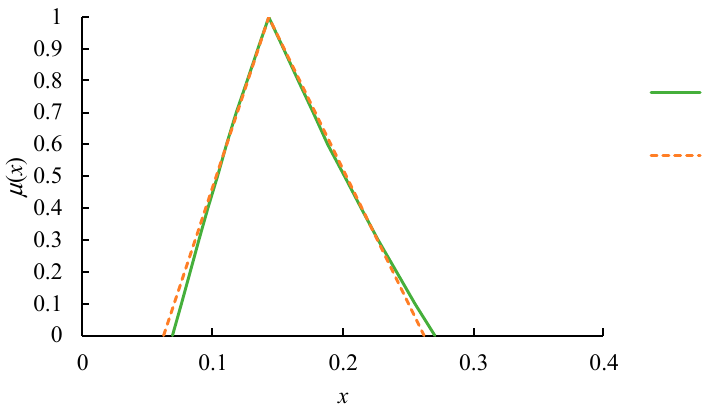
Figure 4. The calibration result.